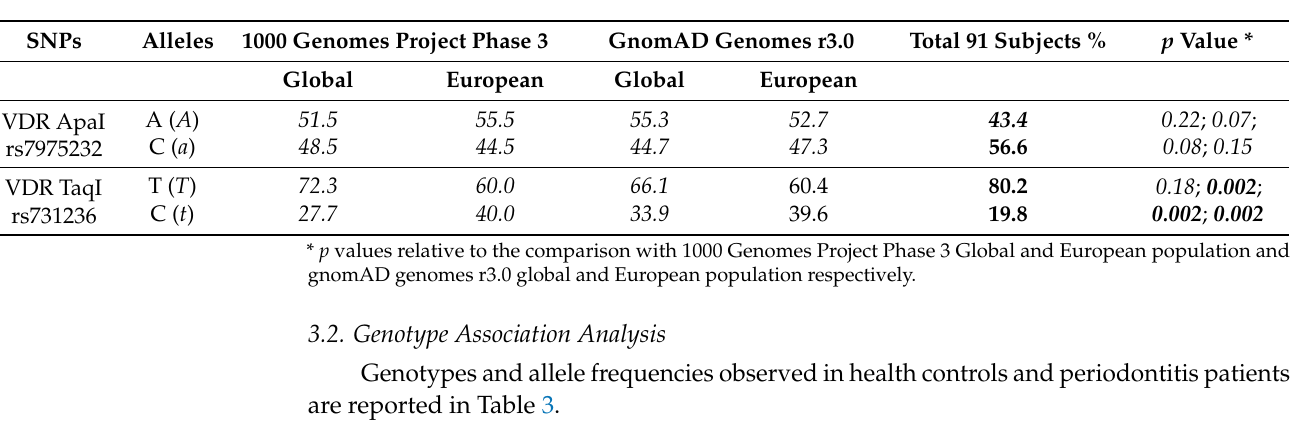
Table 3. Distributions of genotype and allele frequencies of SNPs VDR FokI (Rs2228570),